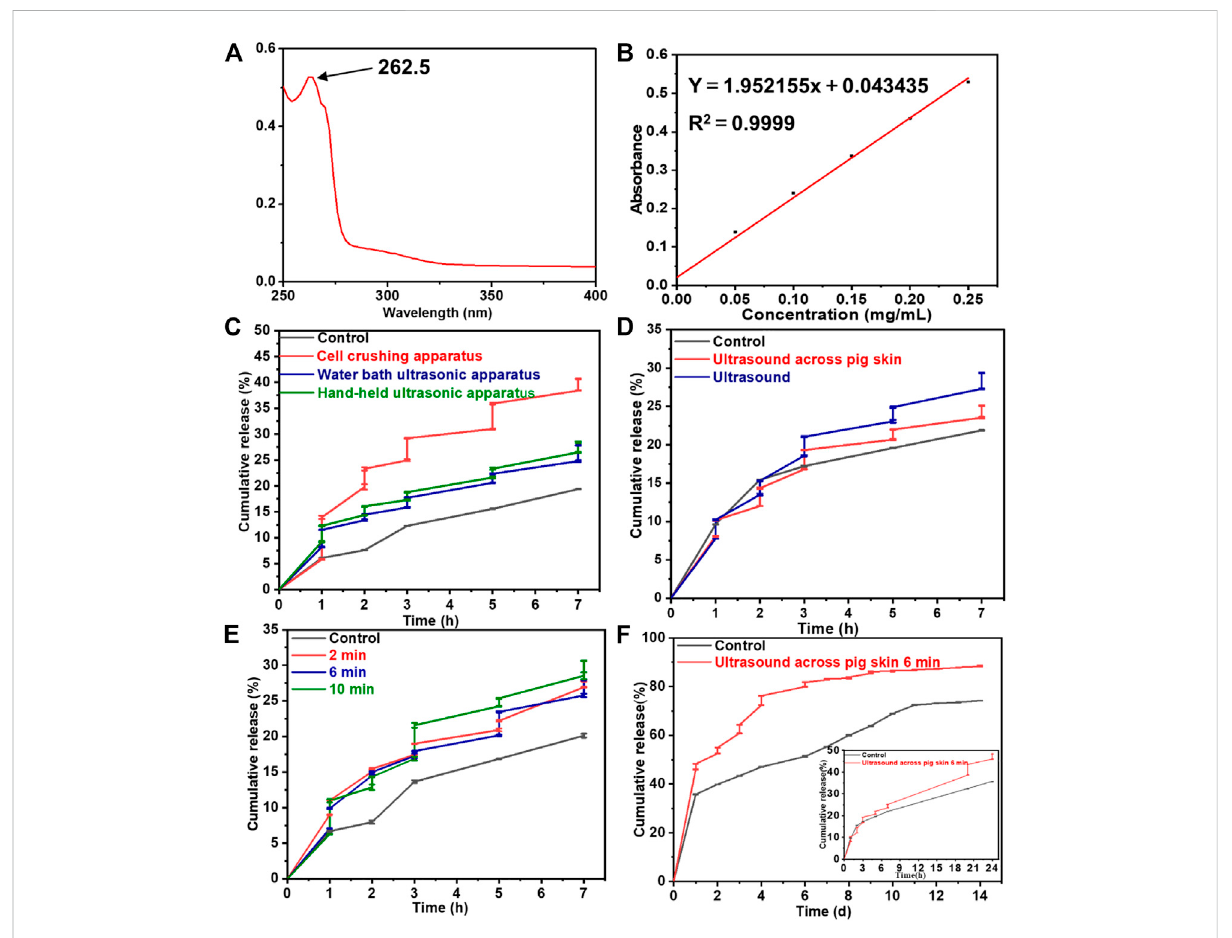
FIGURE 5 (A) The UV-scanning spectrum and (B) the standard curve of lidocaine. The drug release behaviors from Lidocaine@PLGA microcapsules